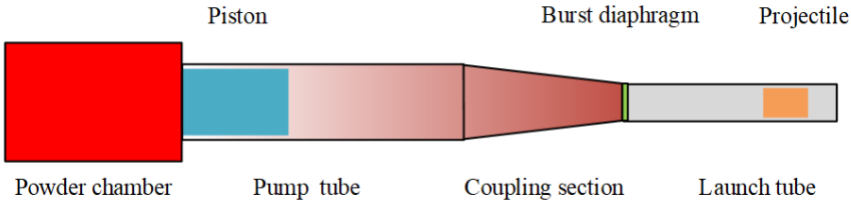
Figure 3. Schematic drawing of two ‐ stage light gas gun.